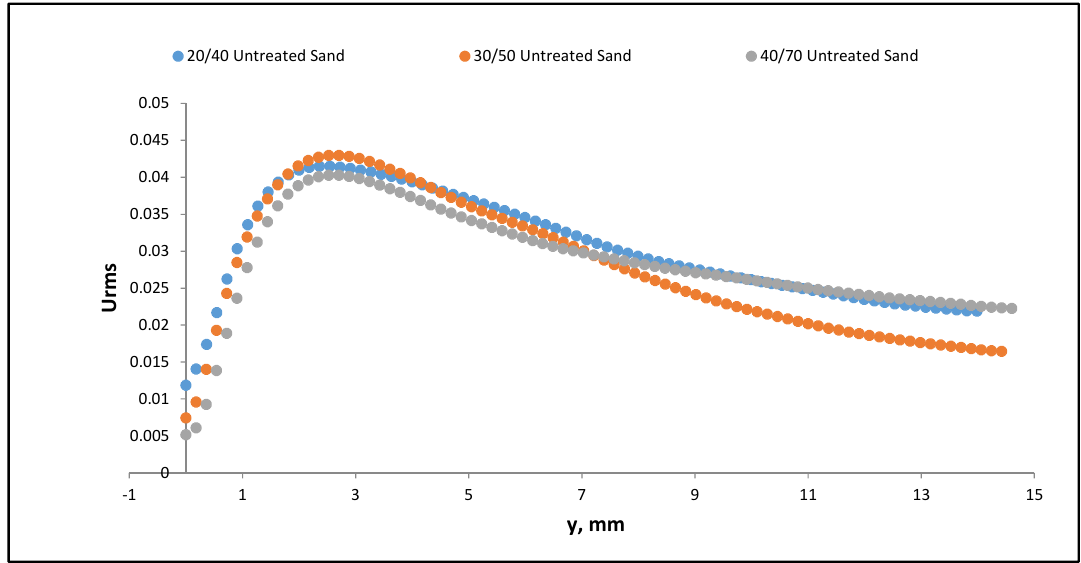
Figure 9. Axial turbulence intensity profiles for the flow of polymer fluid over the sand bed at the superficial velocity of 0.25 m/s.